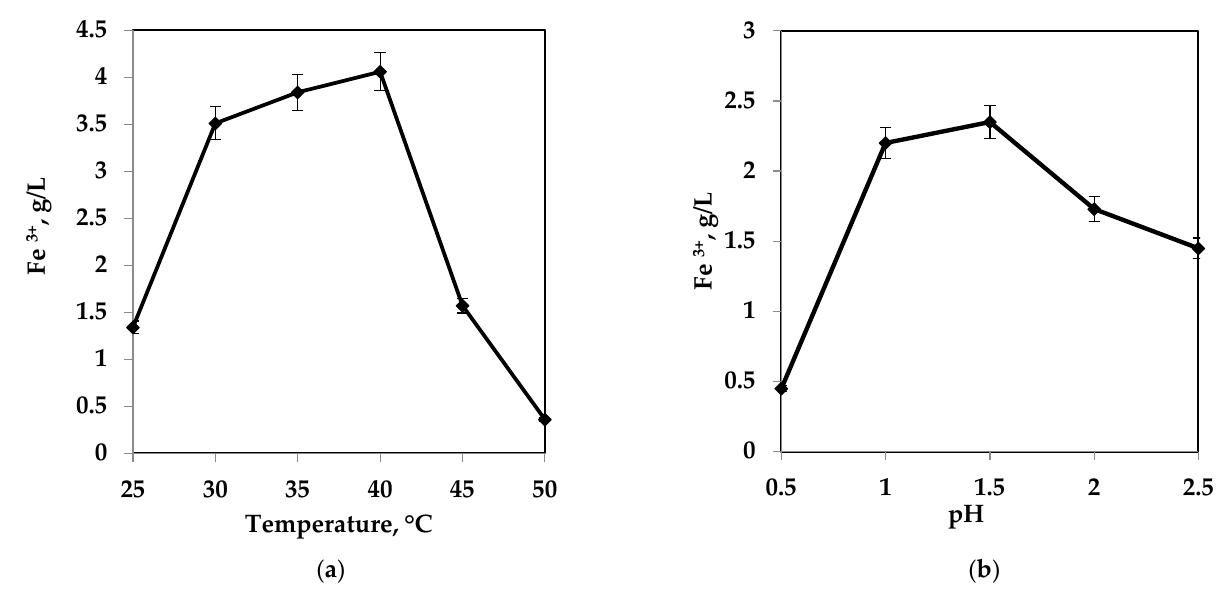
Figure 2. Effect of temperature ( a ) at pH 1.6) and pH ( b ) at temperature 40°C on iron oxidation by L. ferriphilum CC.